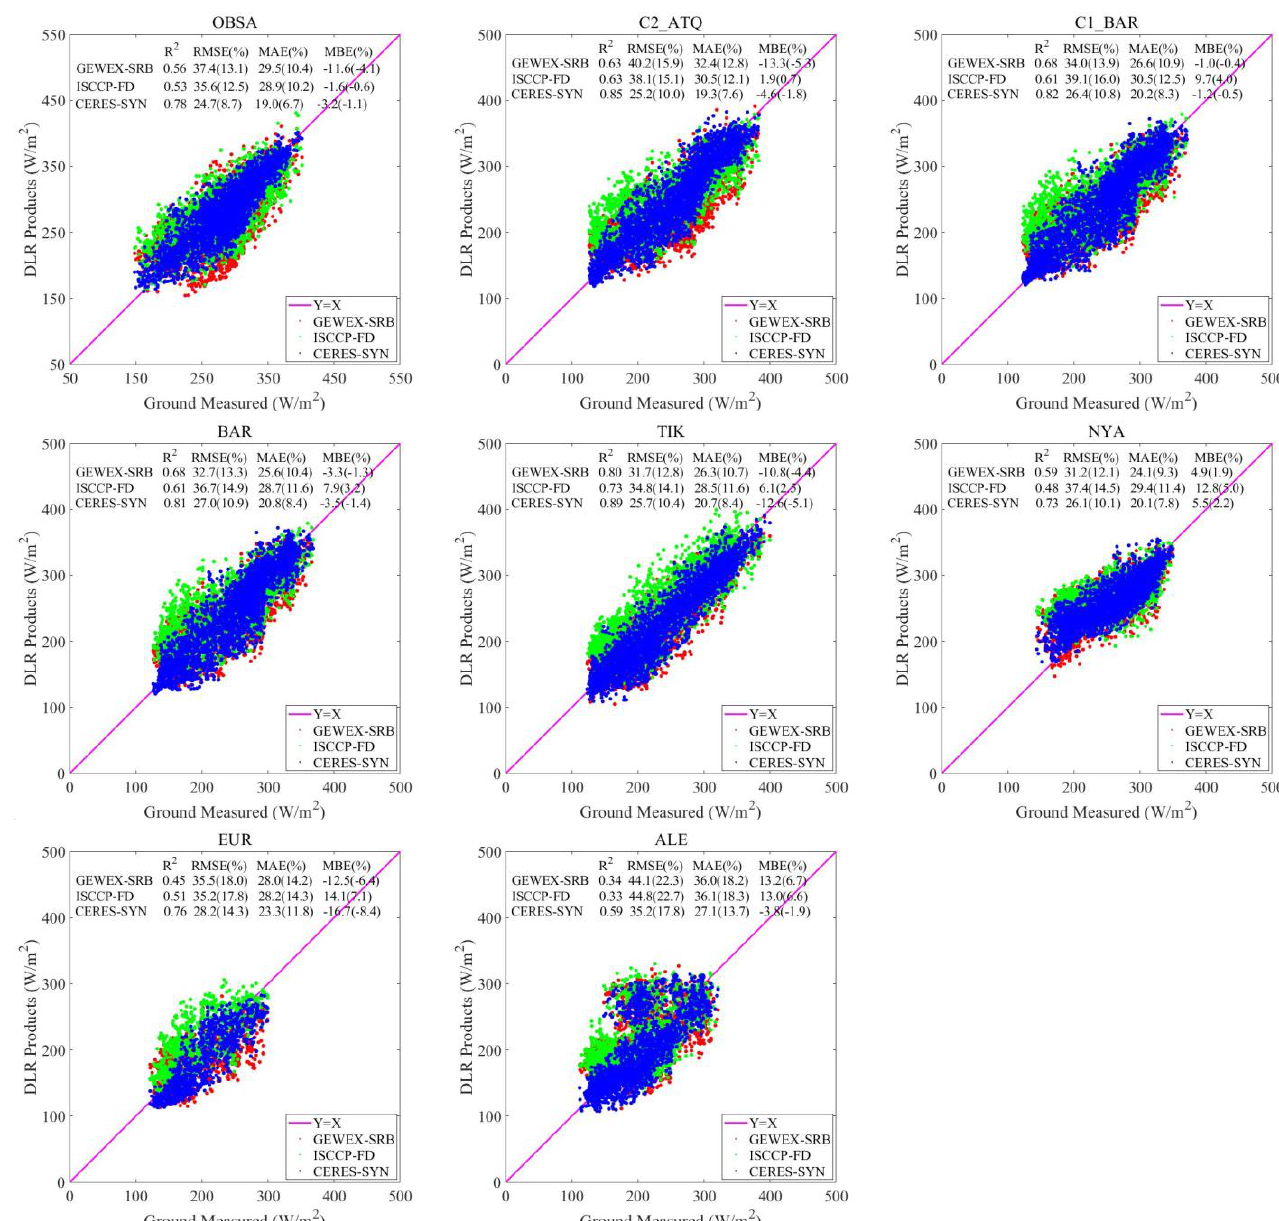
Figure A1. Comparison between ground measurements and 3 h DLR products at all sites.